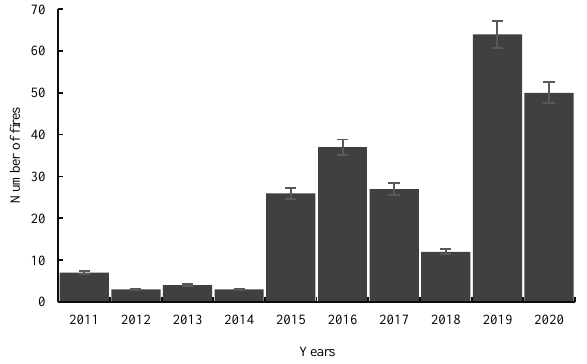
Figure 1: Number of fires recorded from 2011 to 2020 There approximately 11420 hectares of natural areas affected by fire between 2011 and 2020. The minimum-burned area includes 25 hectares that occurred in 2012. Most of the burned natural areas comprises 3992 hectares, which includes 2020 (Figure 3).